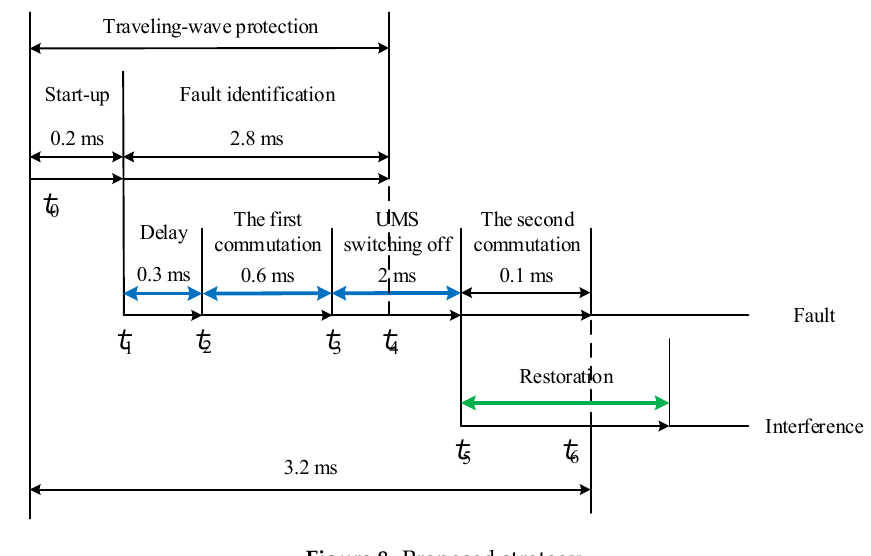
Figure 8. Proposed strategy.